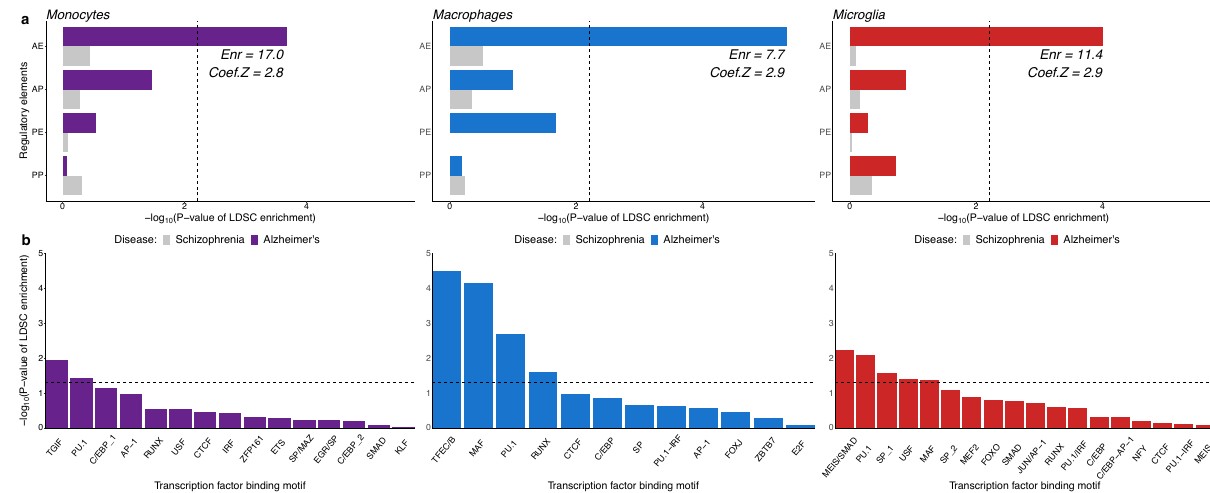
Fig. 1 AD risk alleles are speci fi cally enriched in myeloid active enhancers and in putative transcription factor binding sites located in these enhancers. a -Log10 of enrichment P -values obtained from strati fi ed LD Score Regression (LDSC) analysis of AD SNP heritability partitioned by active enhancer (AE), active promoter (AP), primed enhancer (PE) and primed promoter (PP) annotations in monocytes, macrophages, and microglia. Enr = Enrichment of AD SNP heritability partitioned by active enhancer annotations. Dashed line indicates the Bonferroni-corrected signi fi cance threshold. The enrichment standard errors for active enhancers are 3.8, 1.3, and 2.6 for monocytes, macrophages, and microglia, respectively. b -Log10 of enrichment P -values obtained from strati fi ed LD Score Regression (LDSC) analysis of AD SNP heritability partitioned by ATAC-Seq subsets. The subsets were obtained by stratifying ATAC- Seq regions in monocytes, macrophages, and microglia by the presence of the binding motif of TFs (listed on the x-axis) that were found to be overrepresented in active myeloid enhancers and expressed in monocytes, macrophages, and microglia, respectively (TPM ≥ 1) 15 . Dashed line indicates the nominal signi fi cance